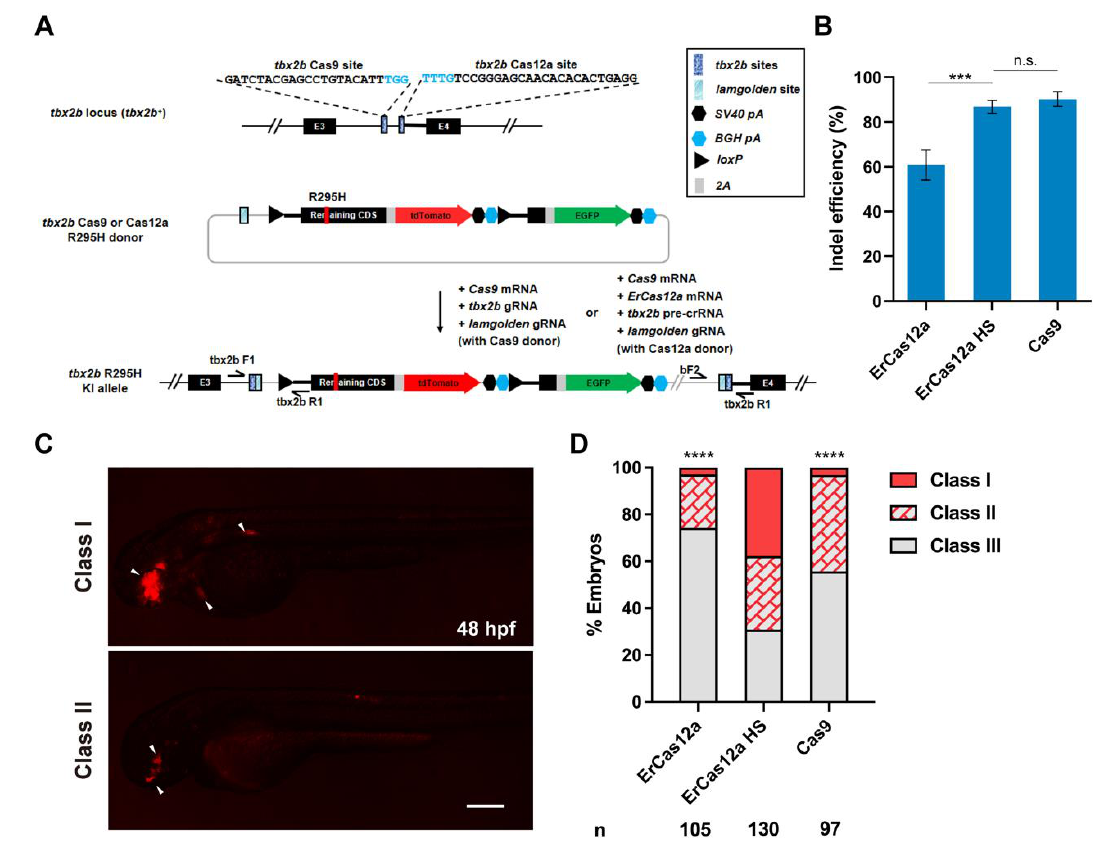
Figure 3. ErCas12a mediates efficient NHEJ-based knockin at the zebrafish tbx2b locus. ( A ) Schematic diagram of R295H mutation and reporter gene knockin mediated by the NHEJ pathway through ErCas12a or Cas9 targeting at the tbx2b locus. Target site sequences are displayed, with PAM sequences indicated in blue. ( B ) Comparison of indel efficiency of tbx2b Cas9 site with ErCas12a site with or without 1 h heatshock at 34 °C. HS: heatshock. Data represent mean ± s.d. of at least three independent replicates. Unpaired two-tailed Student’s t -test was used to calculate p values (*** p < 0.001; “n.s.” indicates the difference is not significant). ( C ) Representative fluorescence expression of tbx2b knockin F 0 embryos obtained by injection of either ErCas12a or Cas9 NHEJ systems. Embryos with red fluorescence were separated into broad (Class I) and sparse (Class II) groups according to the expression pattern. Embryos with no fluorescence were designated Class III. The embryos are in lateral view with anterior to the left. Arrows indicate the regions showing red fluorescent signal. Scale bar: 200 μ m. ( D ) Evaluation of NHEJ-based knockin efficiency by the proportion of broad (Class I) and sparse (Class II) fluorescence-positive embryos injected with ErCas12a or Cas9 systems at the tbx2b locus. The ErCas12a system injected embryos were separated into heatshocked (ErCas12a HS) and control (ErCas12a) groups. Number of embryos evaluated (n) is shown for each condition. Chi-square test was used to calculate p values between heatshocked (ErCas12a HS) group and others (**** p < 0.0001).